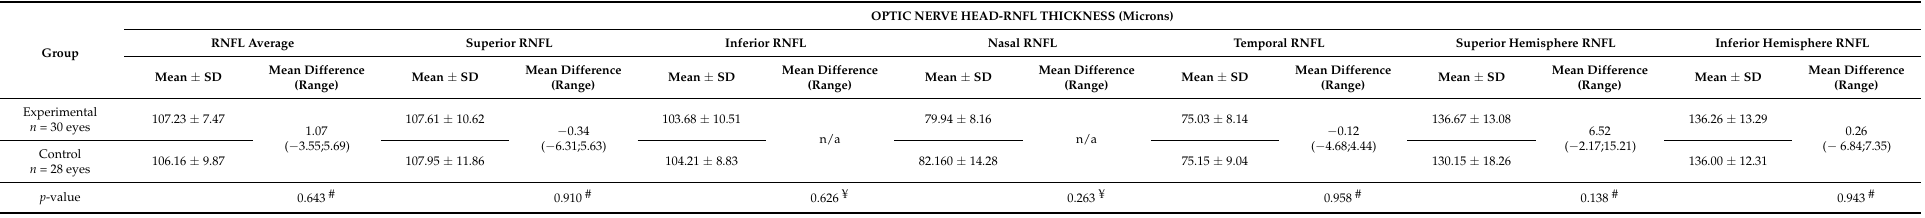
Table 2. A comparison of retinal nerve layer thickness (microns) at the optic nerve head between the presumed systemic hypotensive (experimental) and normotensive (control) participants.